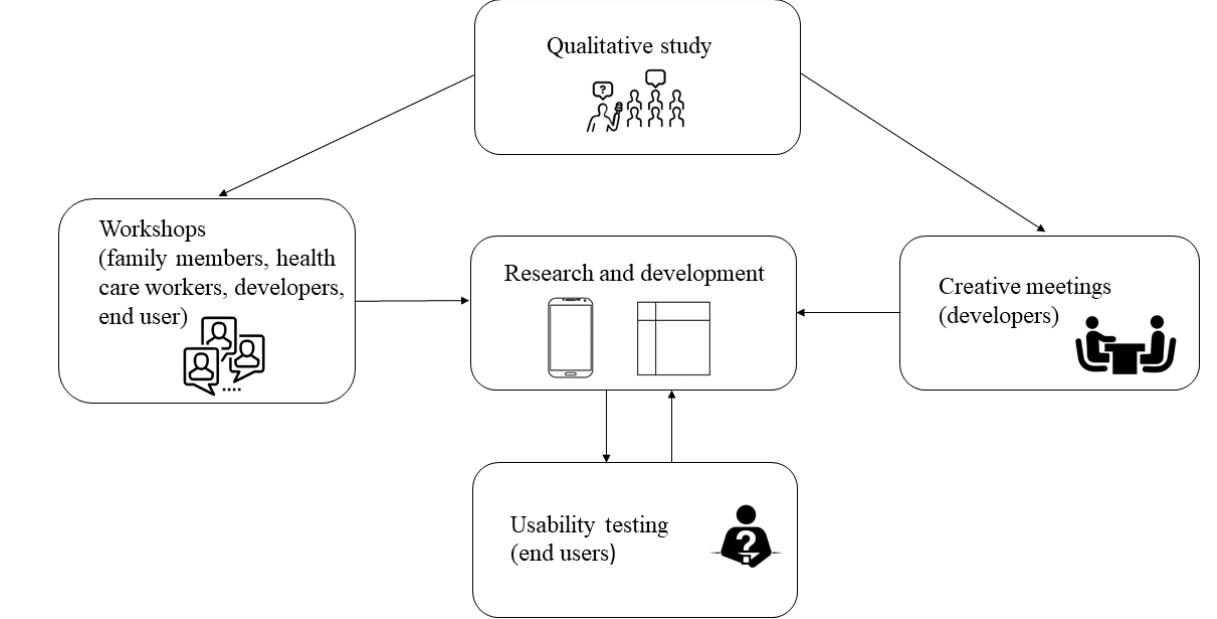
Figure 1. Development process of the electronic health support component of the study.